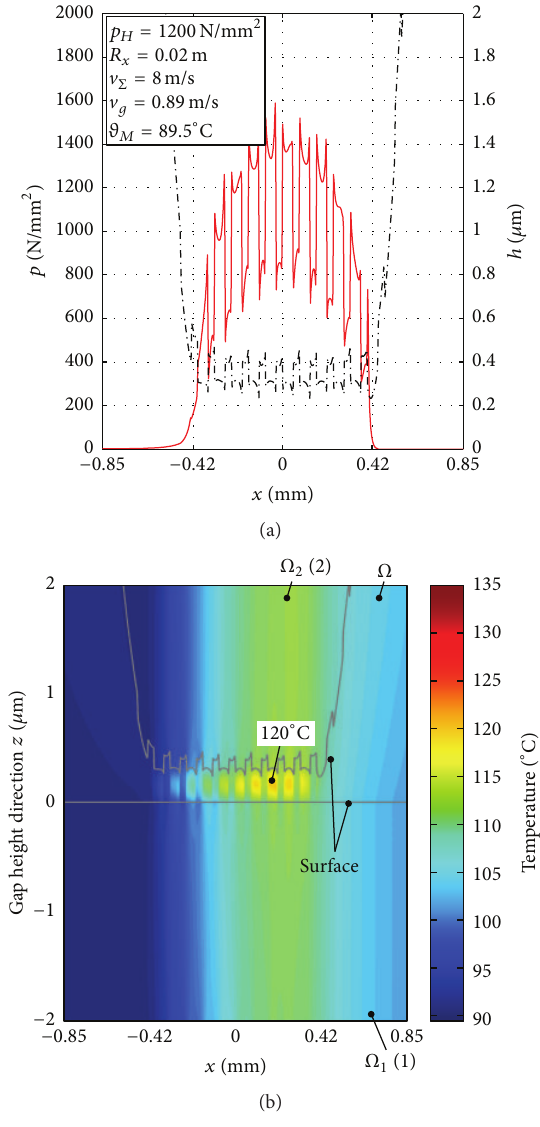
Figure 9: Temperature (a) and pressure and film thickness dis- tribution (b) of a transient TEHL contact with a deterministically structured surface shown in Figure 8.